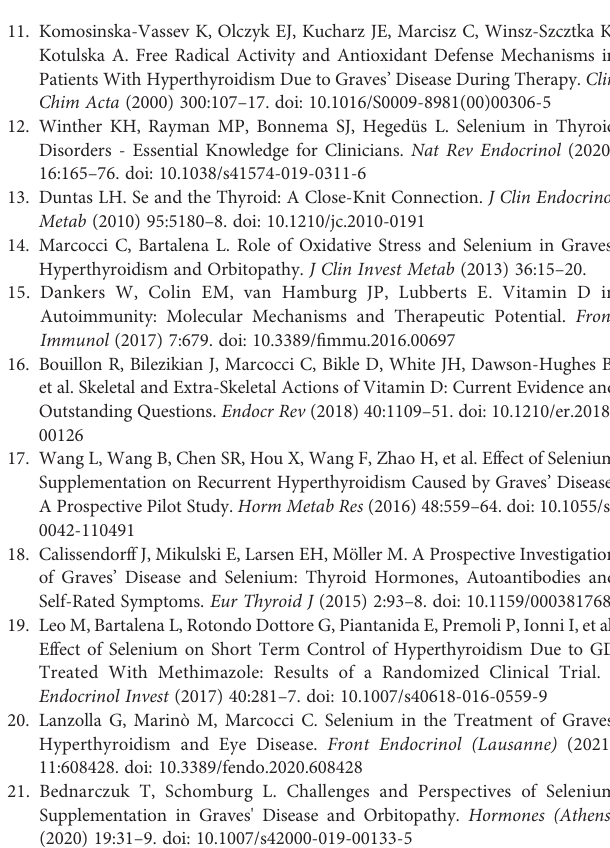
Supplementary Table 1 | Temporal changes of QoL scales investigated by 39 items Thyroid-speci fi c quality of life patient-reported outcome questionnaire (ThyPRO). p-value*= p-value for interaction between time course and treatment group (period of evaluation: 0-6 months and 6-9 months); p-value**= p-value for intergroup comparison. social, social life impairment; goiter, symptoms related to the presence of enlarged thyroid gland; hyperthyroid, symptoms related to hyperthyroidism, ThyPRO, Thyroid-speci fi c quality of life patient-reported outcome questionnaire. Supplementary Table 2 | Temporal changes of handgrip strength test (kg/s). p- value*= p-value for interaction between time course and treatment group (period of evaluation: 0-6 months and 6-9 months); p-value**= p-value for intergroup